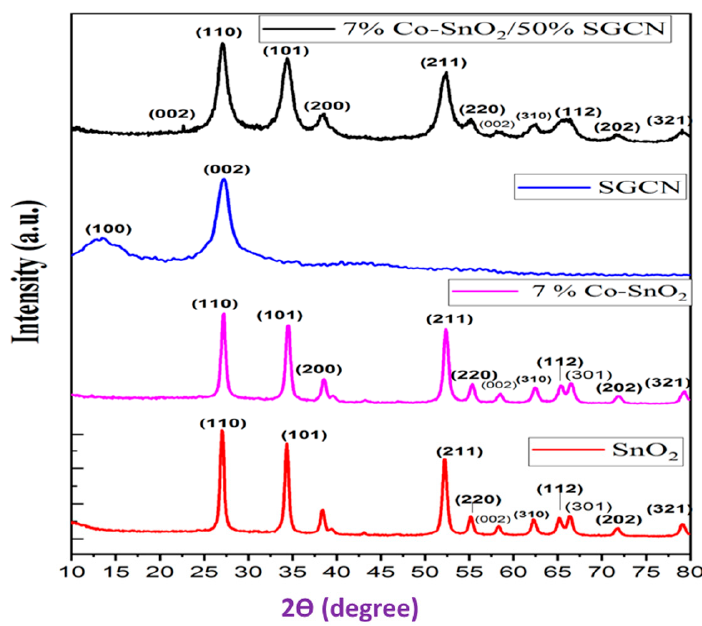
Figure 1. XRD pattern of SnO 2 , 7%Co-SnO 2 , SGCN, and 7%Co-SnO 2 /50% SGCN.